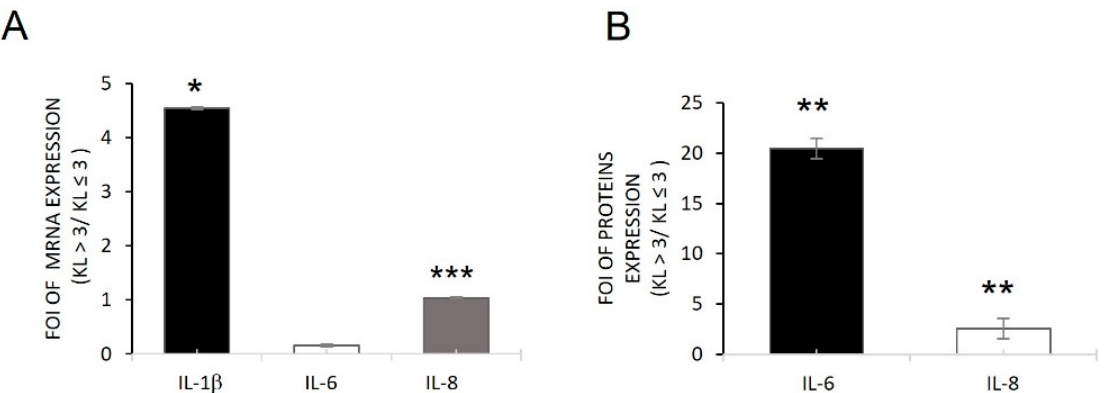
Figure 1. Interleukin expression in osteoblasts derived from OA patients. qRT-PCR ( A ) and ELISA ( B ) analysis of IL-1 β , IL-6, and IL-8 gene expression in OBs derived from OA patients. Data are reported as FOI of expression between the KL > 3 group/KL ≤ 3 group (mean ± SD, n = 4). Student’s t -test: *, p < 0.05; **, p < 0.005; ***, p < 0.0005.